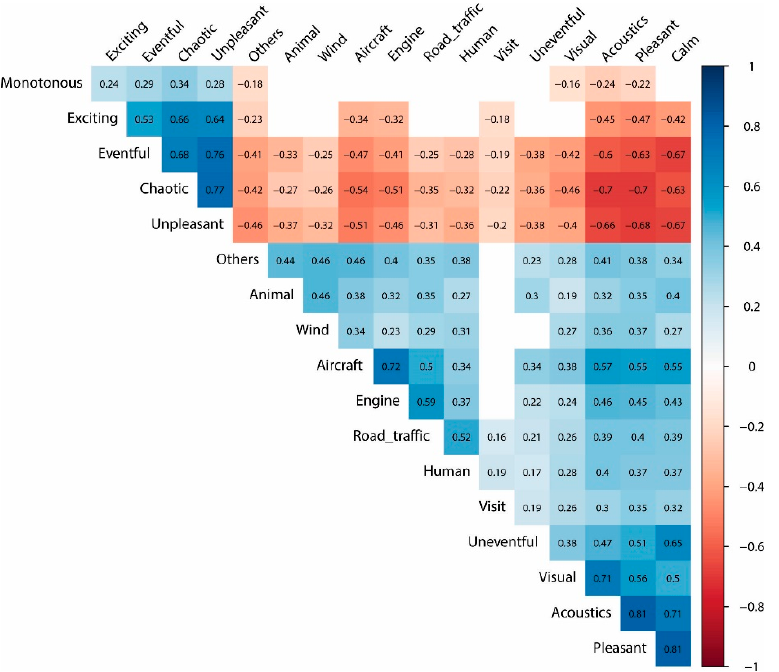
Figure A1. Spearman’s correlation coefficients between the subjective ordinal variables of the study.